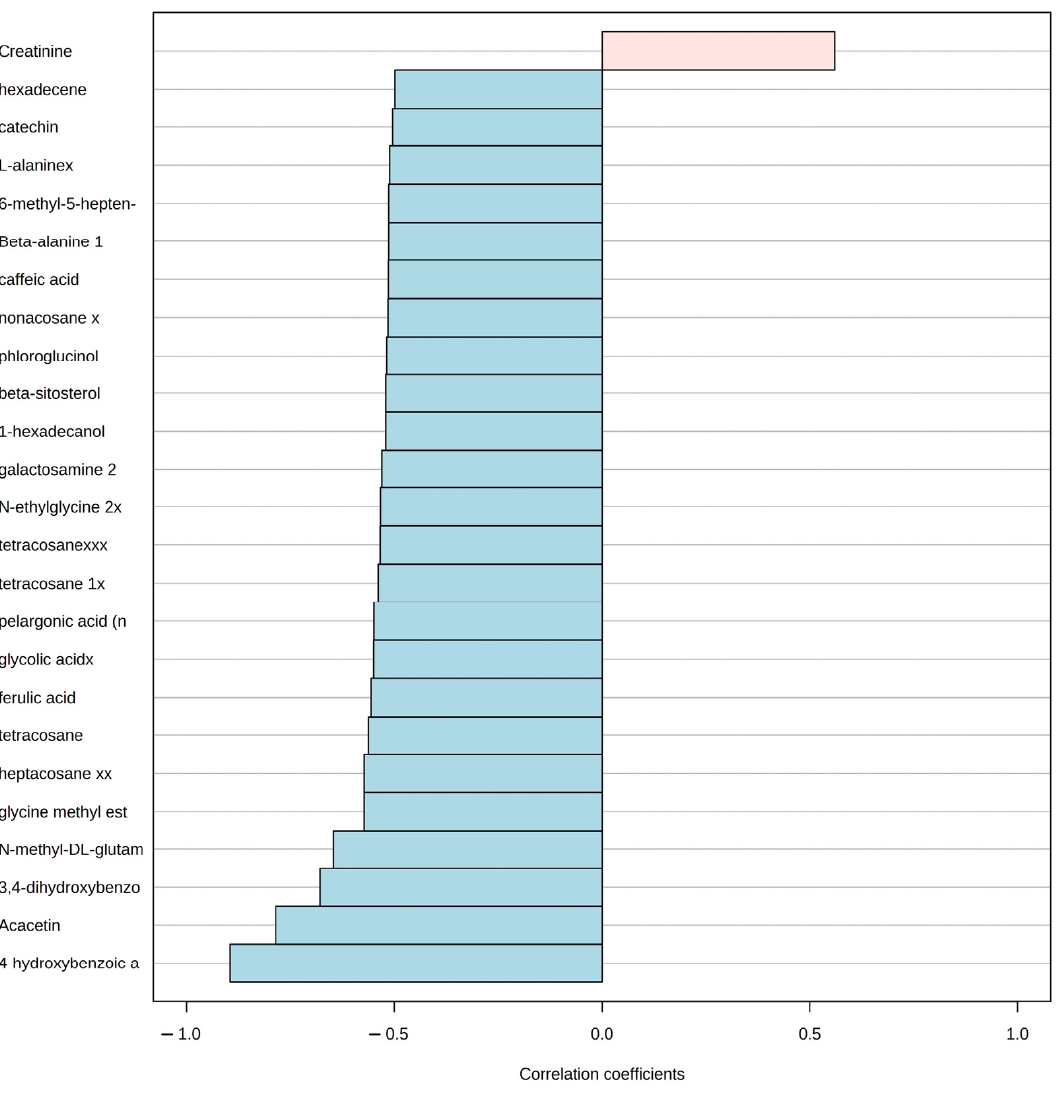
Figure 5. Pattern hunter analysis for P. lividus , showing the top 25 metabolite spectra bins related to the distance of aquaculture nutrient enrichment in the direction from station A to B. Light red indicates a positive relationship with proximity to fish farm, while blue indicates a negative one. Correlation coefficient: nonparametric Spearman correlation.